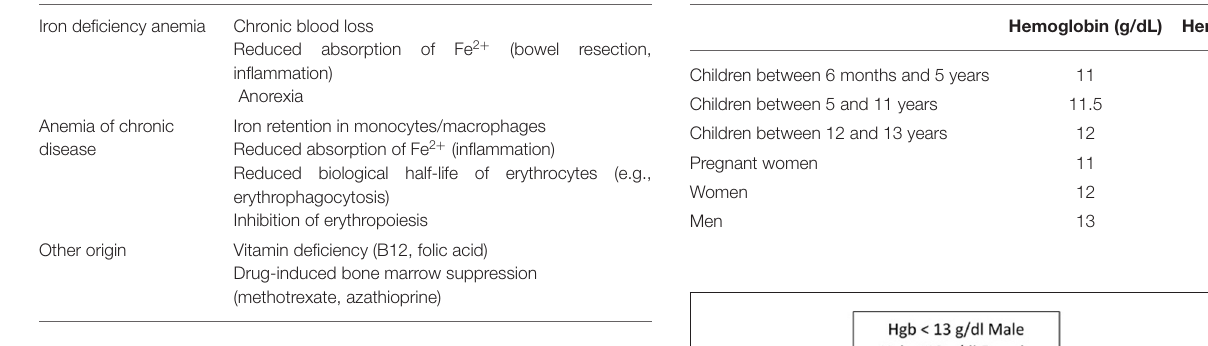
TABLE 3 | Pathomechanisms of different type of anemias in IBD. TABLE 4 | World Health Organization’s anemia criteria.